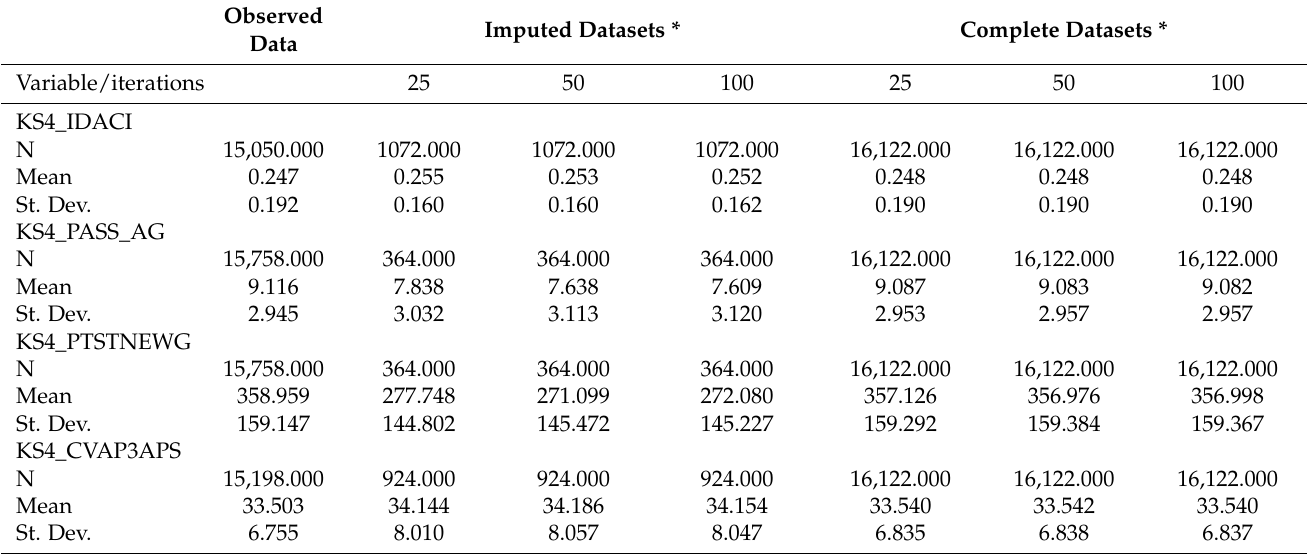
Table 1. Descriptive statistics for the observed data, the five imputed datasets and the five complete